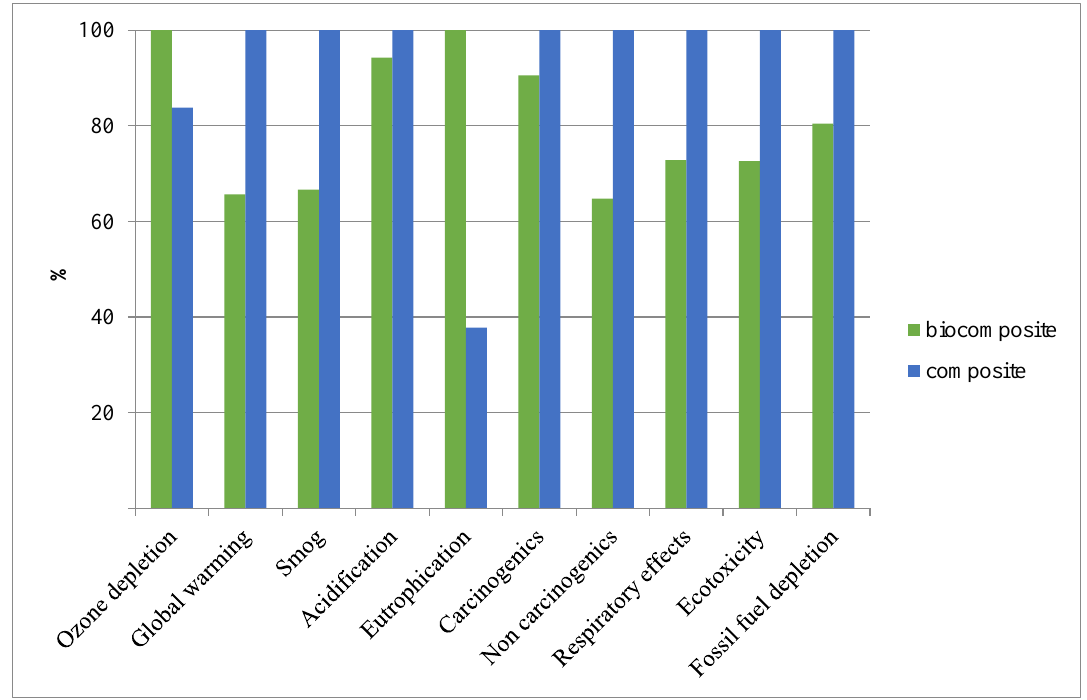
Figure 6. Comparing the environmental impacts of producing 1 kg of biocomposite with 1 kg of BPA-based composite using the TRAI 2 method.